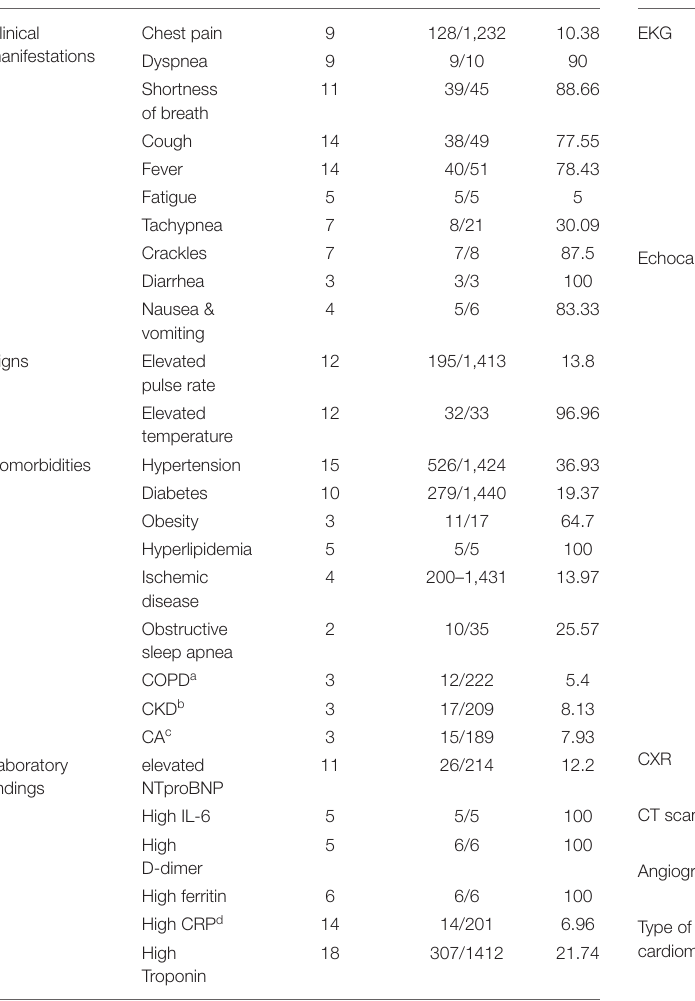
TABLE 3 | Clinical and laboratories findings in patients with COVID-19. Variable